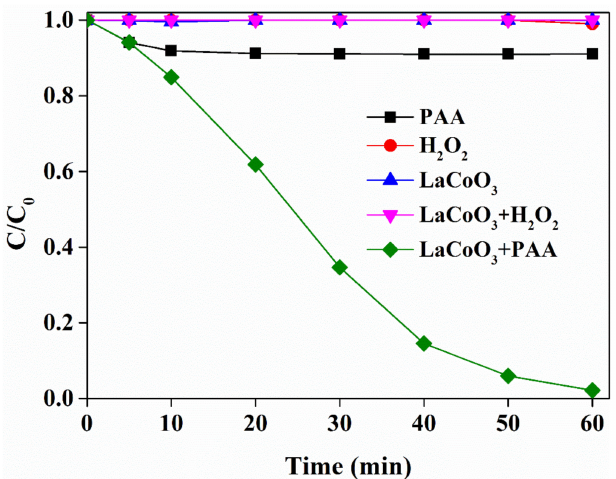
Figure 2. Sulfamethoxazole (SMX) degradation in di ff erent systems. LaCoO 3 = 20 mg / L, SMX = 50 µ M, peracetic acid (PAA) (or H 2 O 2 ) = 660 µ M, pH 7, 25 ◦ C.